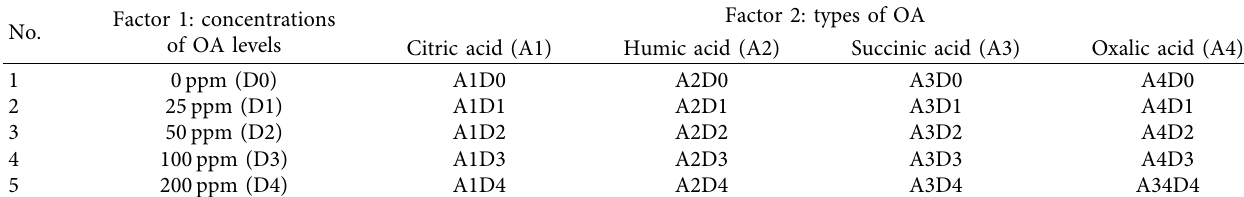
Table 1: Combination of the treatments in a factorial complete randomized design.